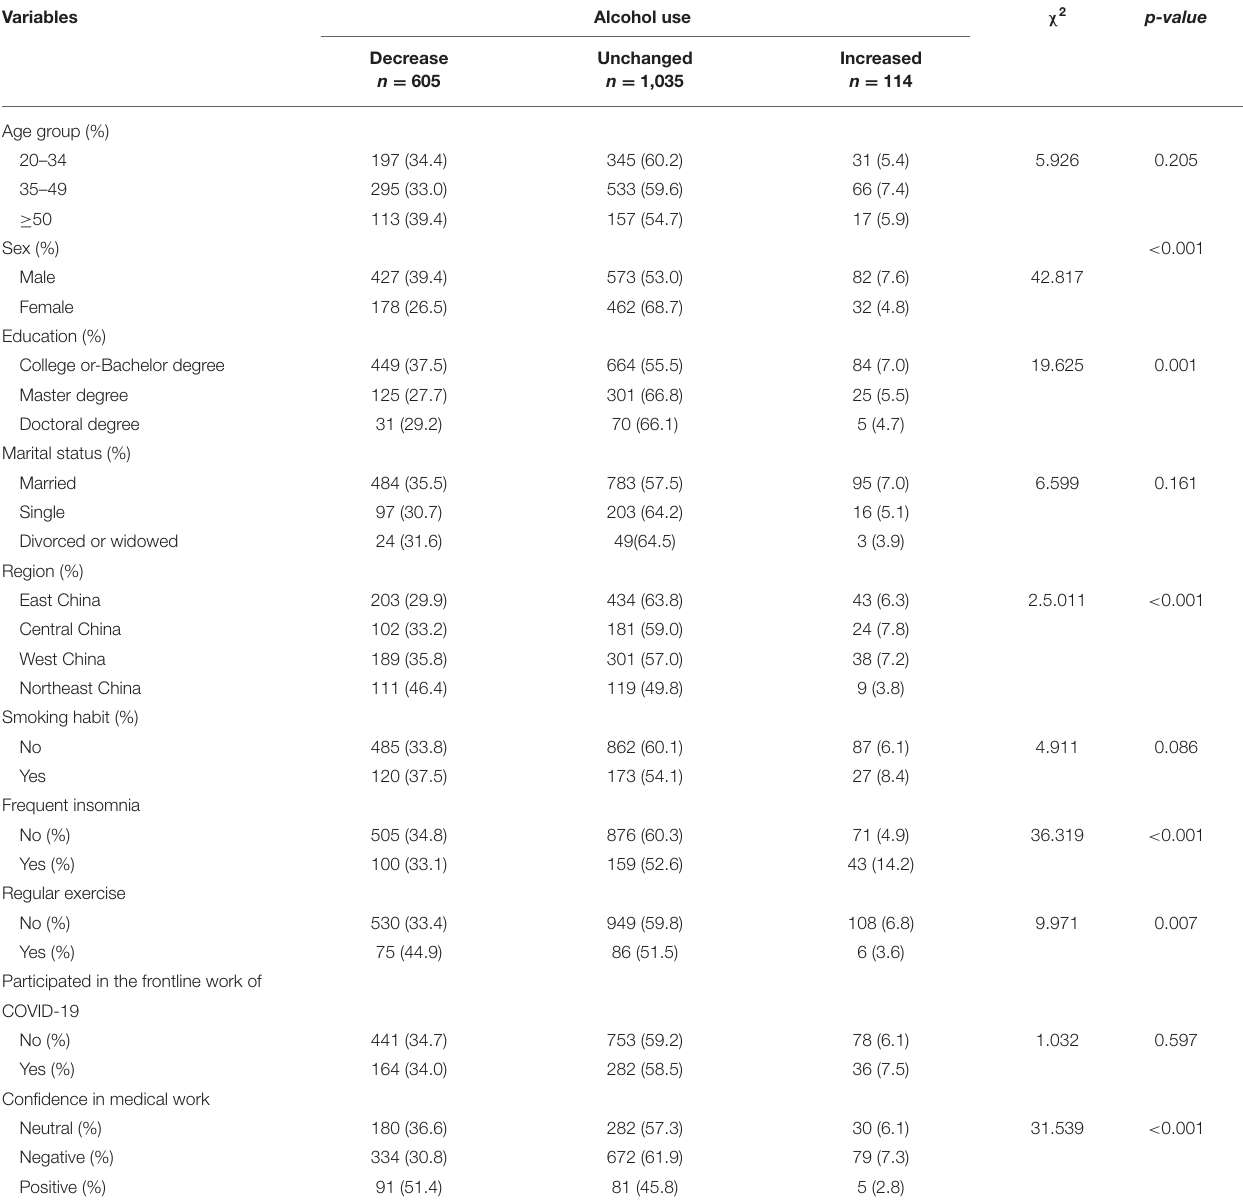
TABLE 3 | Difference between the studied variables and alcohol use changing during the COVID-19 among 1,754 psychiatrists in China.